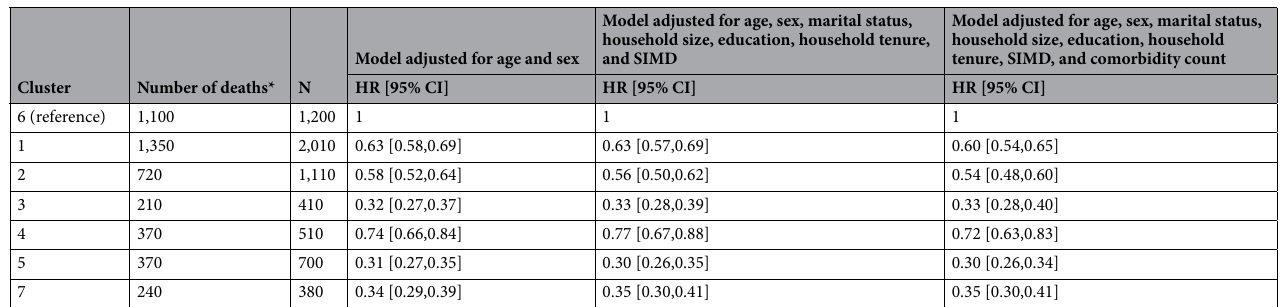
Model adjusted for age, sex, marital status, household size, education, household tenure, SIMD, and comorbidity